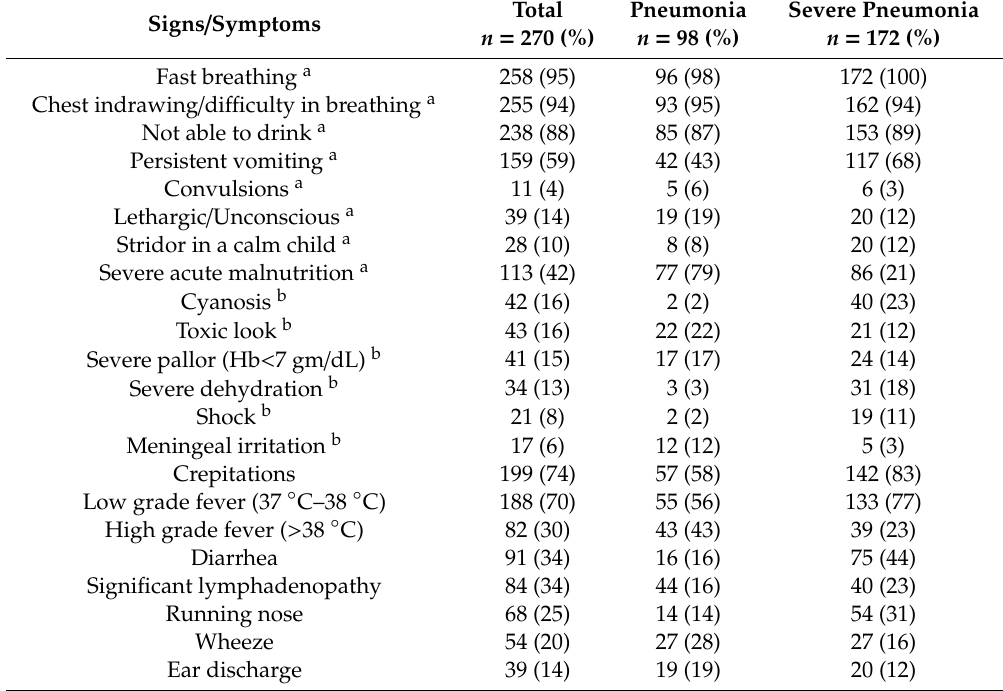
a danger signs according to WHO; b other danger signs, %column percentage.